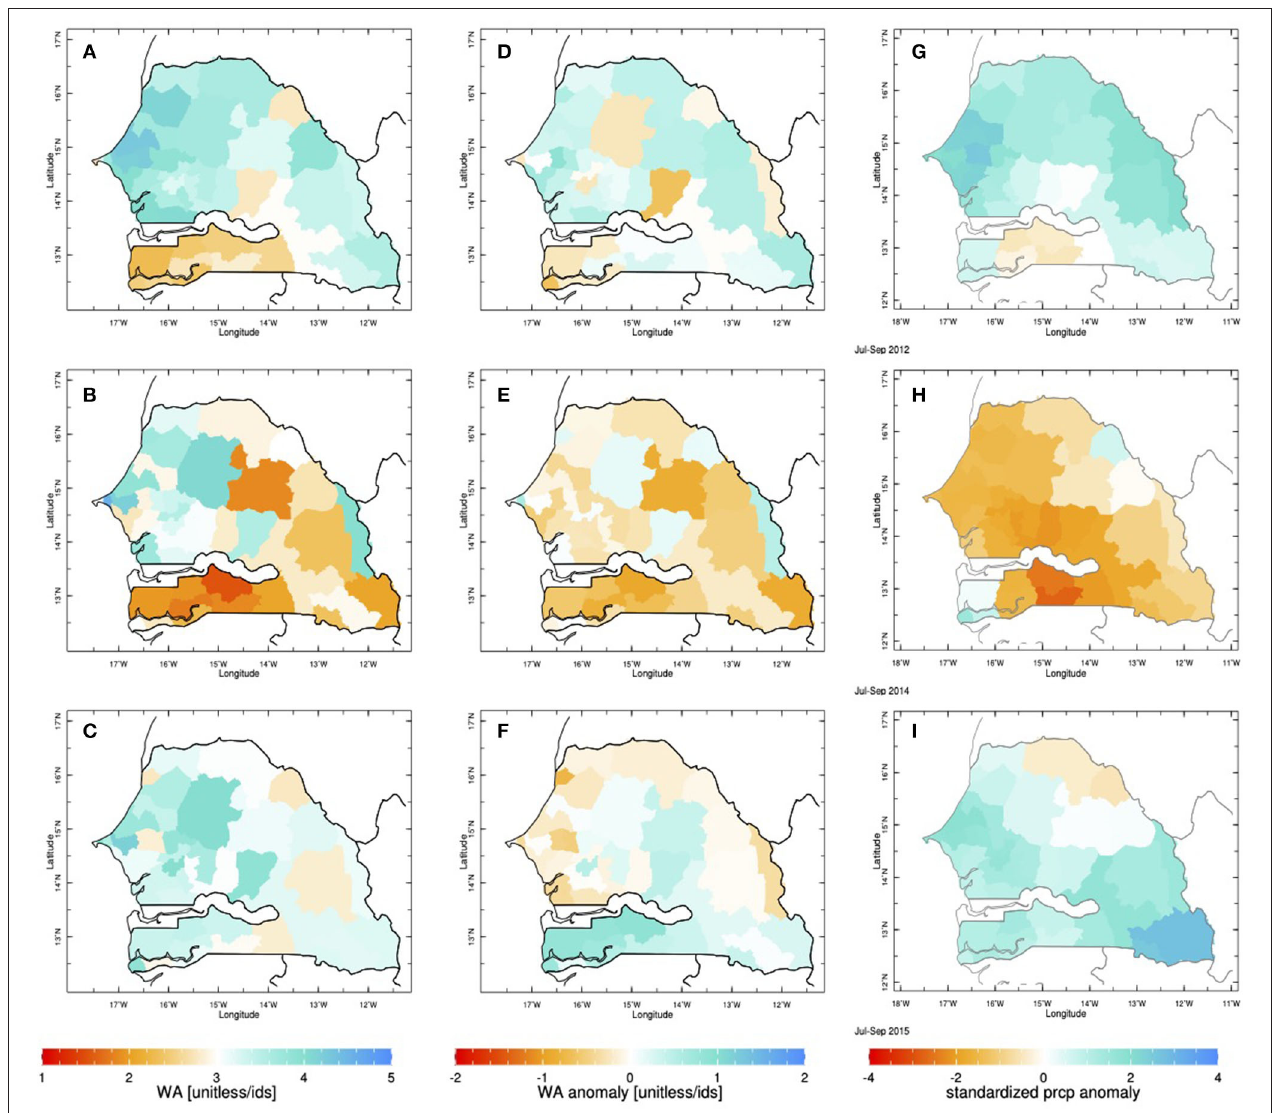
FIGURE 2 | Food security and precipitation across the 3 years surveyed–2013 (A,D,G) , 2014 (B,E,H) and 2016 (C,F,I) . (A–C) depict the weighted average of cluster membership as computed in Equation (1), for each survey: low values, in orange hues, denote lower food security, or a greater prevalence of households in relatively low food security clusters; high values, in blue hues, denote higher food security. (D–F) depict anomalies in the weighted average of cluster membership. These are calculated by removing the average of the three maps in the left column (which is depicted in Figure 1C ) from each map in the left column. In other words, (D) is obtained by subtracting Figure 1C from (A) , (E) by subtracting Figure 1C from (B) , and (F) by subtracting Figure 1C from (C) . (G–I) depict anomalies in precipitation with respect to the 2000–19 average, meaning that the climatology of precipitation depicted in Figure 1A is subtracted from total accumulated precipitation in each